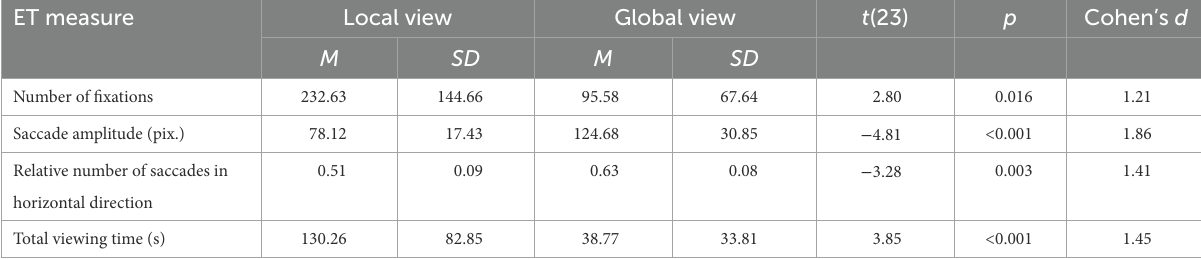
TABLE 5 Descriptive statistics and t -test results for eye-tracking measures of students with a local vs. global view of data. ET measure